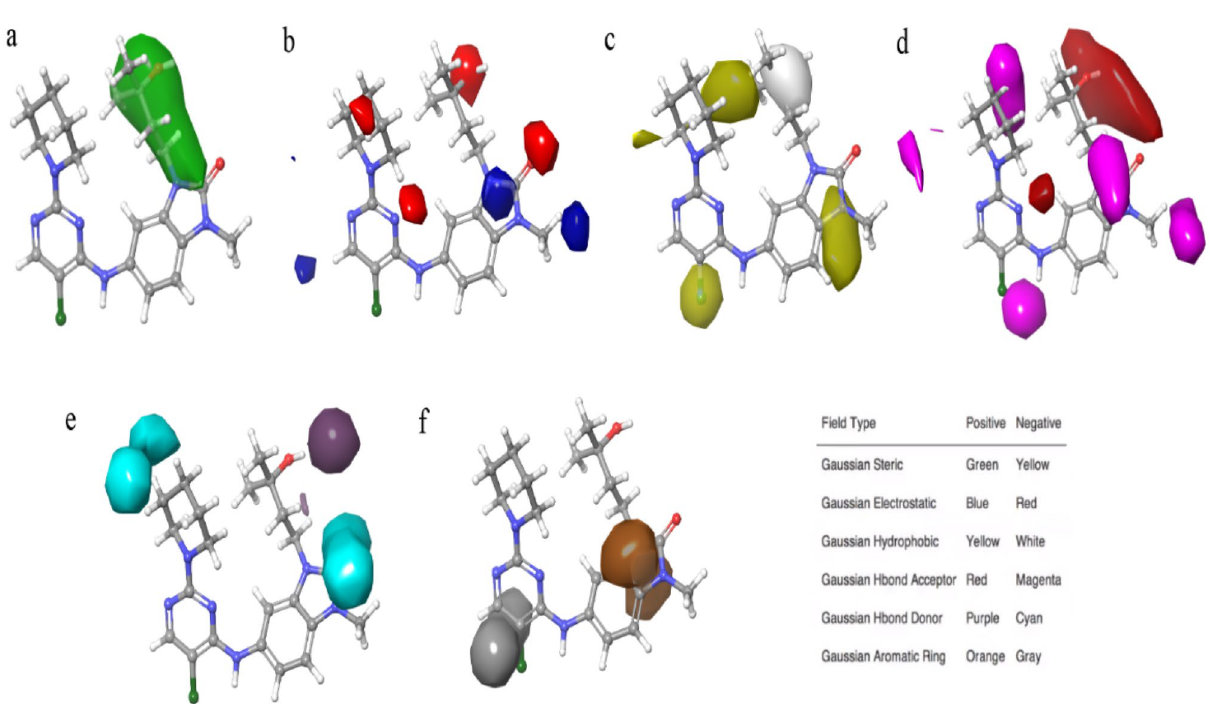
Figure 3. The contour representation of Gaussian steric ( a ), electrostatic ( b ), hydrophobic ( c ), H bond acceptor ( d ), H bond donor ( e ), and aromatic ring ( f ) field fractions are depicted by their intensities. One of the structures of the dataset is illustrated to make the contours more